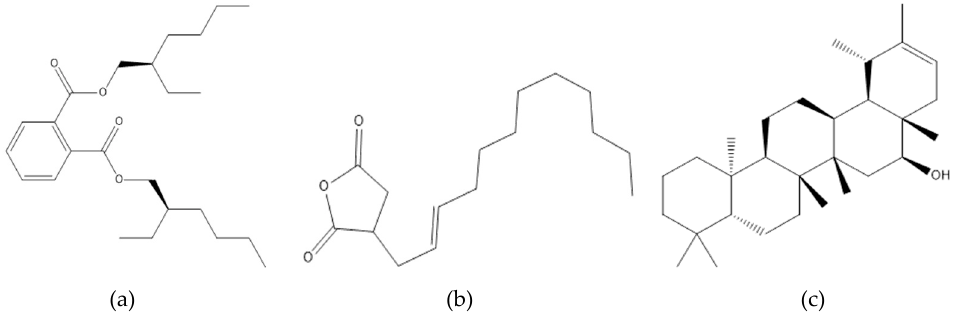
Figure 8. The structure of ( a ) Bis(2-ethylhexyl) phthalate; ( b ) Dodecenyl succinic anhydride; and ( c ) Urs-20-en-16-ol.